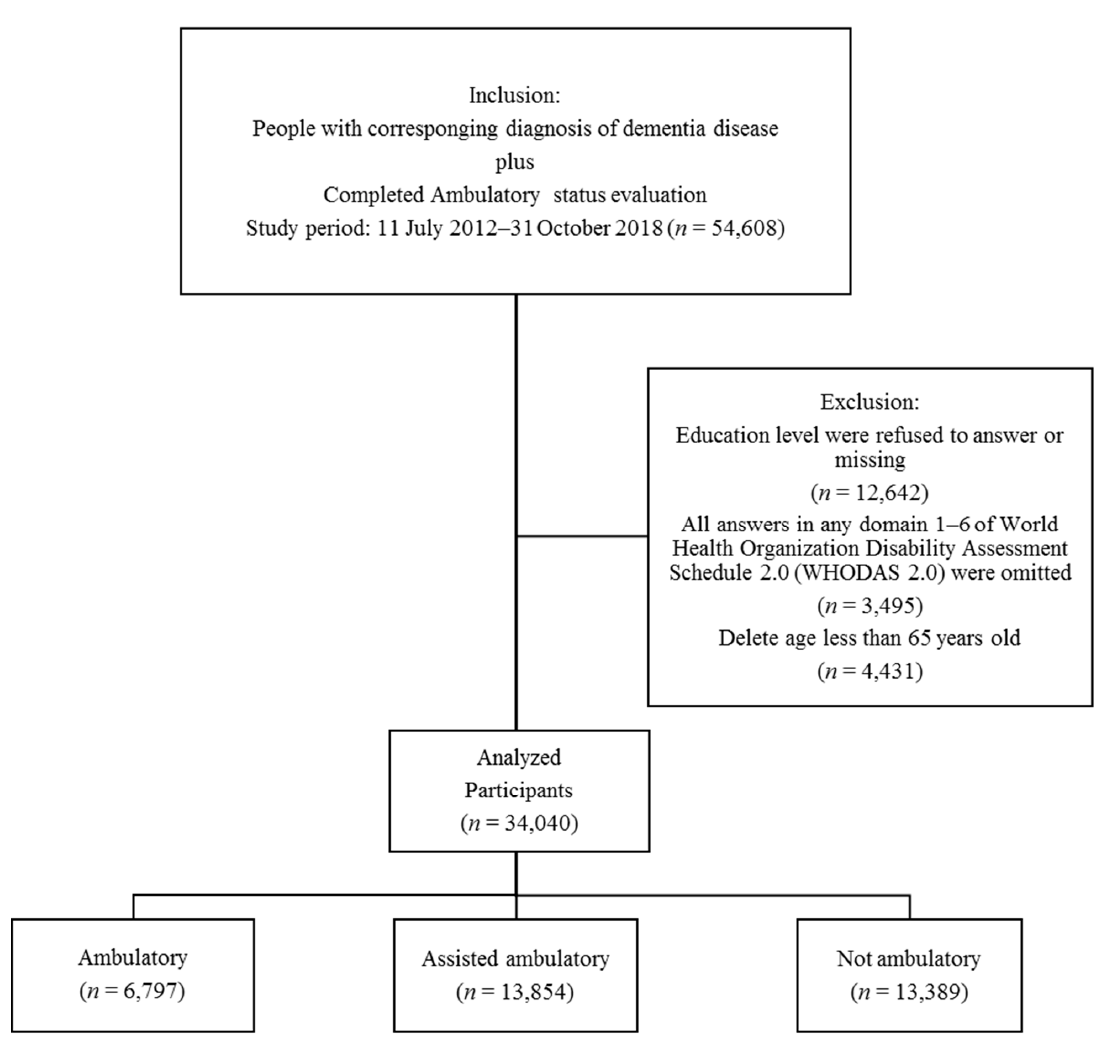
Figure 1. Flow chart of participant selection. In total, 34,040 demented participants with different ambulatory status were included in the